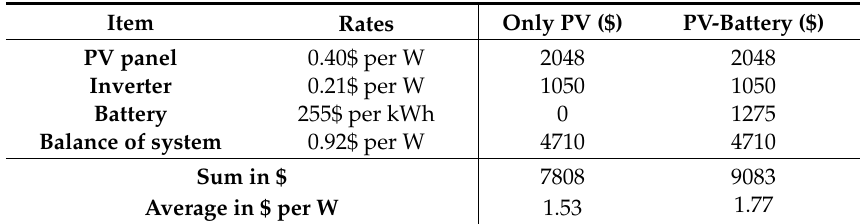
Table 4. Summary of project